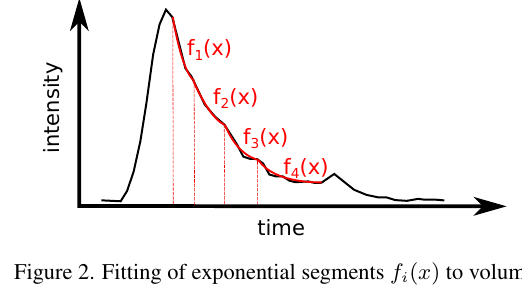
Figure 2. Fitting of exponential segments f i ( x ) to volume backscatter.